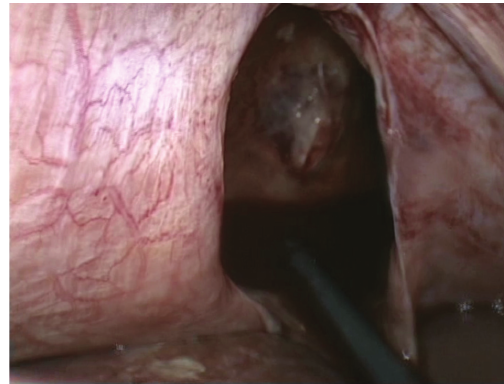
Figure 2: Transdiaphragmatic view into the right thoracic